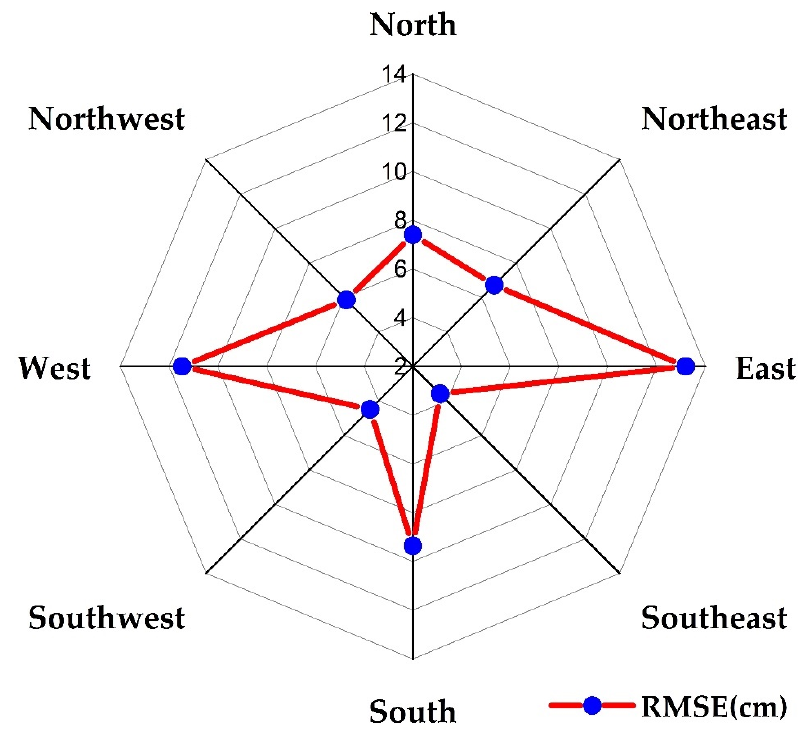
Figure 12. RMSE of downscaled snow depth on different aspects.